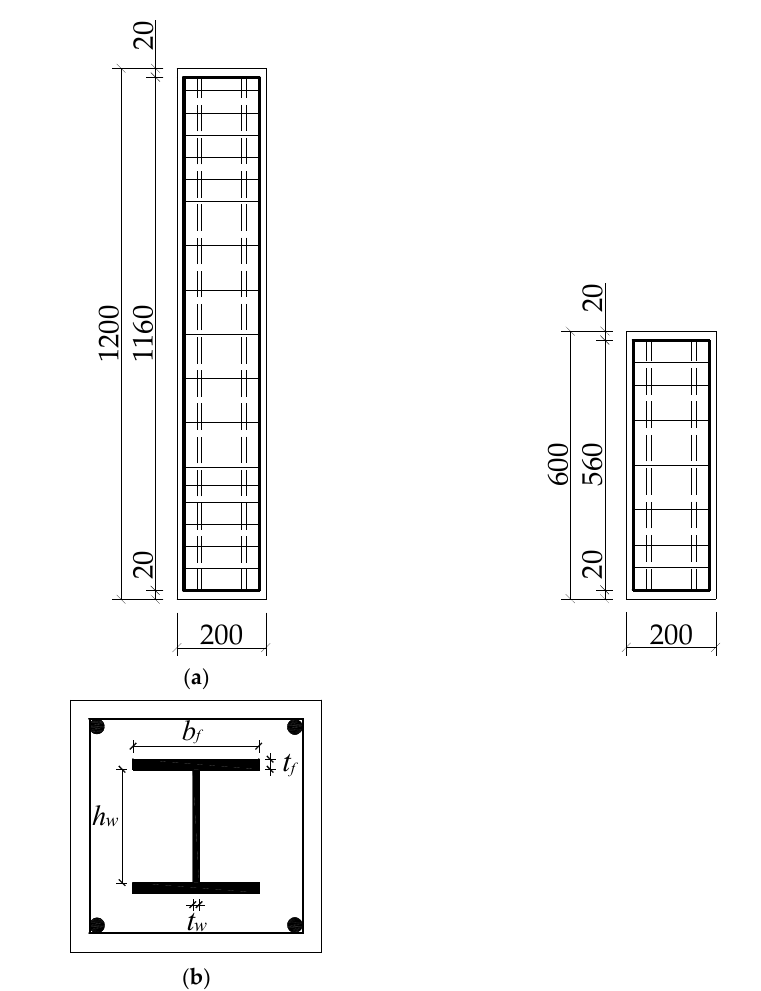
Figure 2. The ( a ) detailed dimensions and ( b ) cross section of the